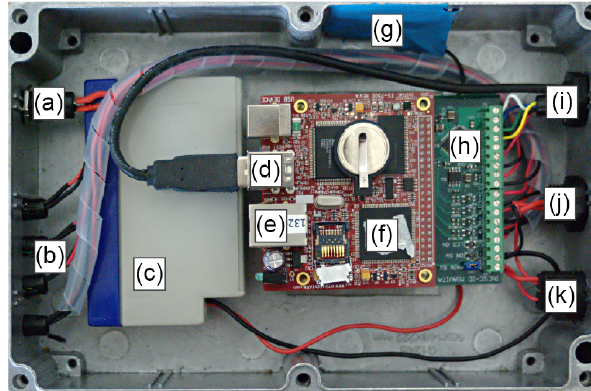
Figure 11. Open case – (a) button for enabling/disabling status LEDs, (b) status LEDs, (c) internal battery, which can be replaced with an external hard drive for sample storage if the user desires, (d) USB connection to an external antenna, (e) Ethernet port, (f) TS- 7500 embedded ARM device, (g) GPS antenna, (h) data acquisition module, (i) geophone connector, (j) power connector, (k) power switch.